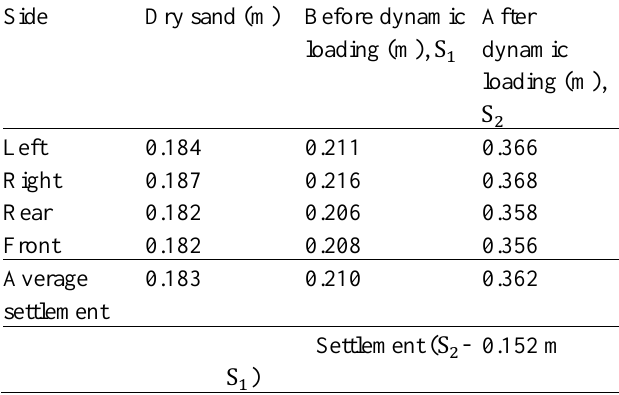
Settlement of Ground from Sides of the Structure in Untreated